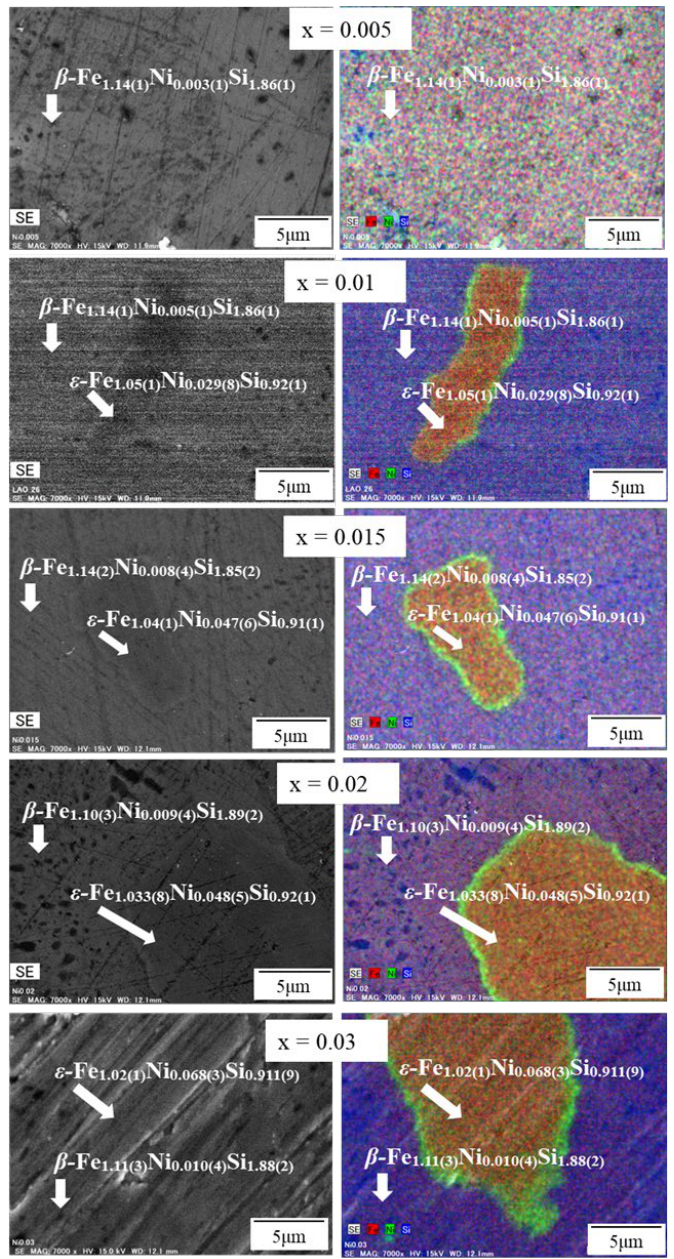
Figure 3. SEM-EDS mapping of β -Fe 1−x Ni x Si 2 (0.005 ≤ x ≤ 0.03). Fe, Ni, and Si are mapped with red, green, and blue, respectively.